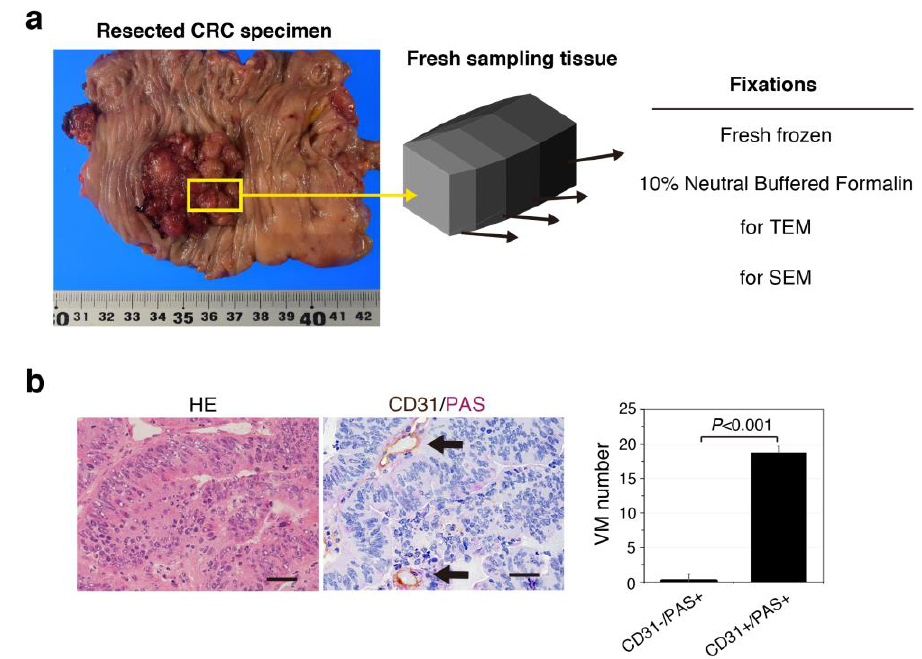
Figure 1. Vasculogenic mimicry (VM) formation defined by CD31 − / PAS + expression is uncommon in patient-derived colorectal cancer (CRC) tissues. ( a ) Image of a surgical specimen obtained from a human CRC patient. Cubic-shaped tissues of 10 × 5 × 5 mm were resected from normal-appearing tissue and cancerous lesions. The samples were sectioned and used accordingly. ( b ) Images of HE-staining (left) and CD31/PAS expression (right) in CRC tissues. Arrows indicate CD31+/PAS+ capillary vessels, but not VM formation. Scale bars represent 50 μm. ( b ) VM quantification in five CRC tissue samples. Data: Averages ± standard deviations.